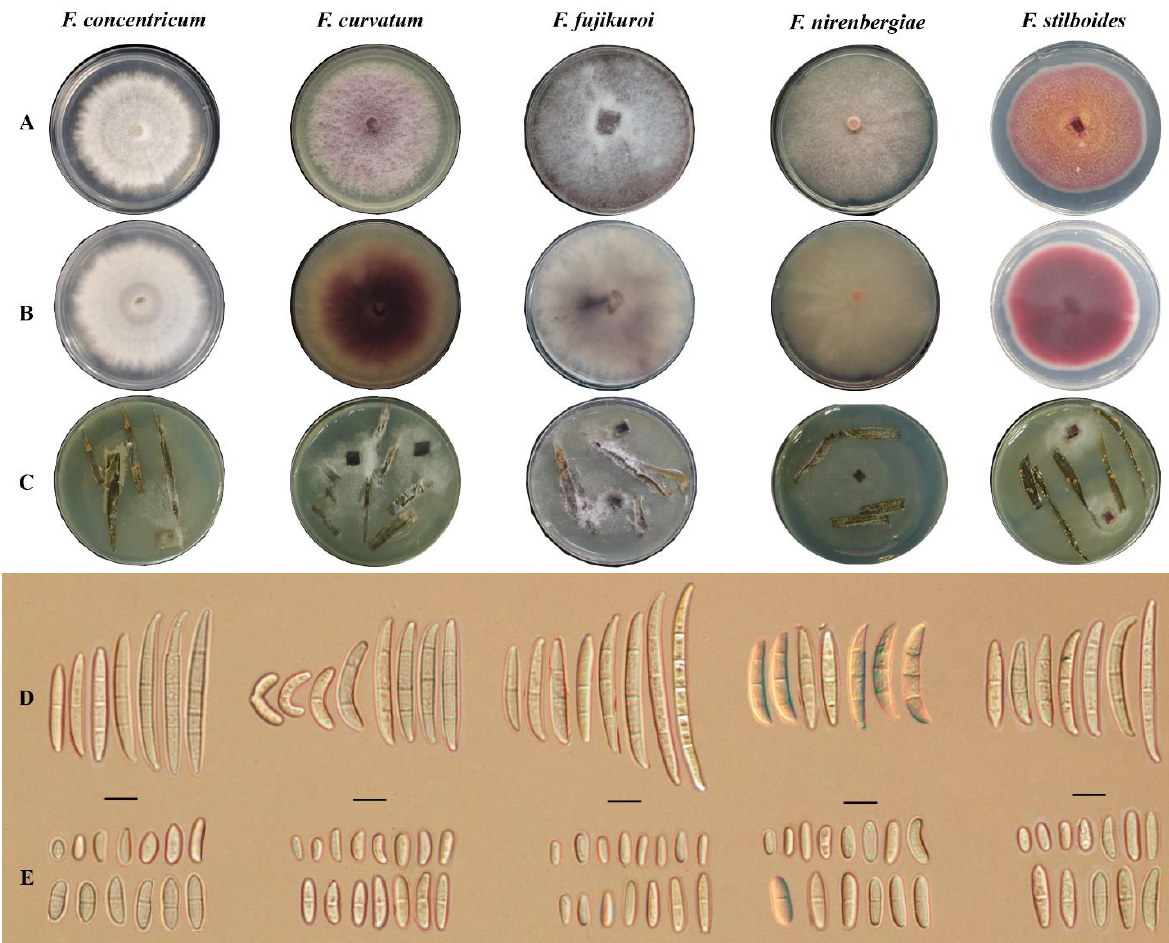
Figure 2. Morphological characteristics of Fusarium species isolated from infected Dendrobium offic- inale stems. ( A ) Front side on PDA; ( B ) Reverse side on PDA; ( C ) Sporodochia on Carnation Leaf Agar; ( D ) Macroconidia; ( E ) Microconidia. Scale bars: D – E= 10 µm.